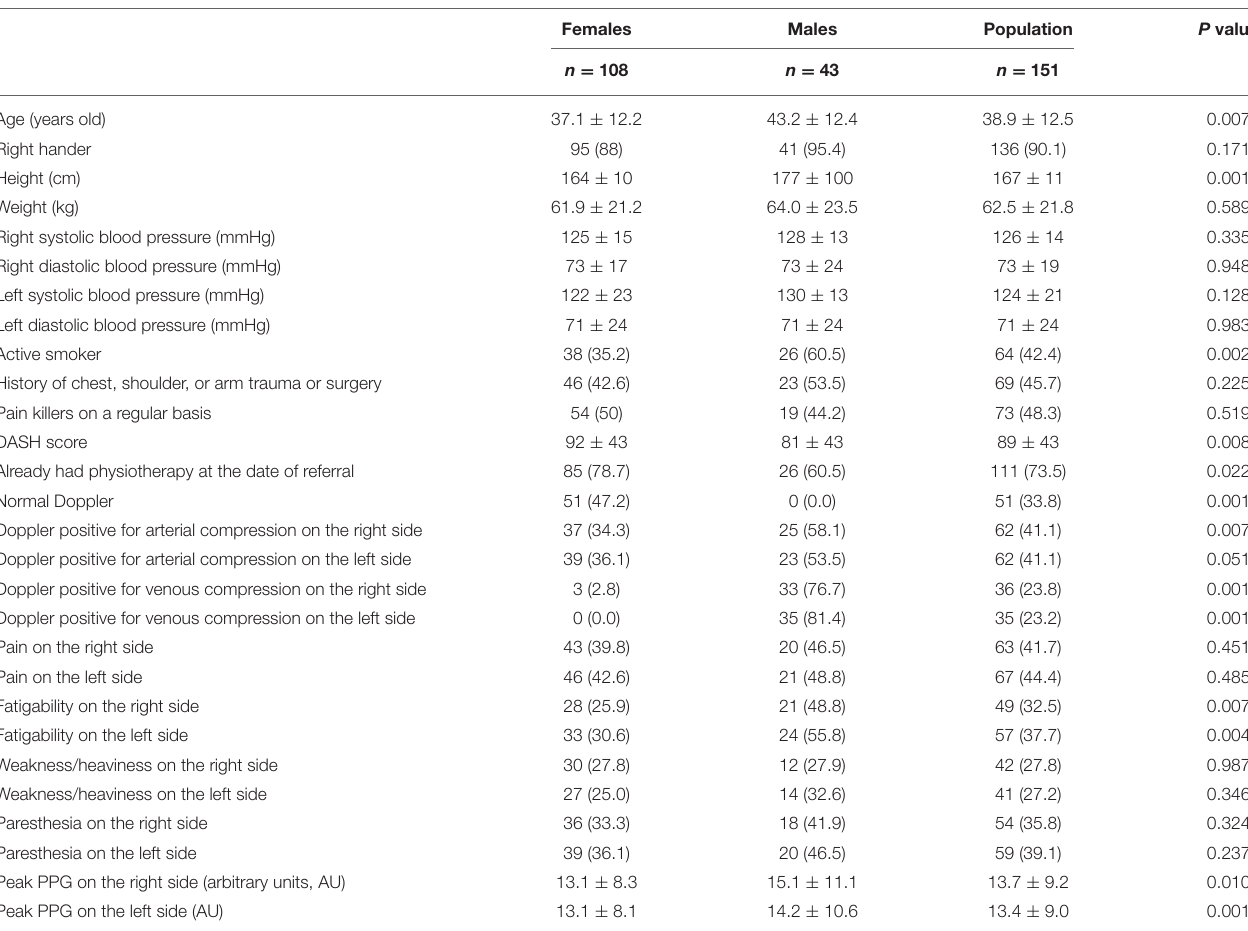
TABLE 1 | Characteristics of the population and comparison by